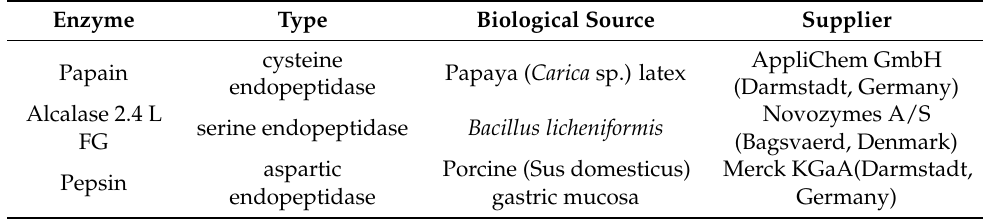
Table 1. Sources, types and supplier of the enzymes used in this study.